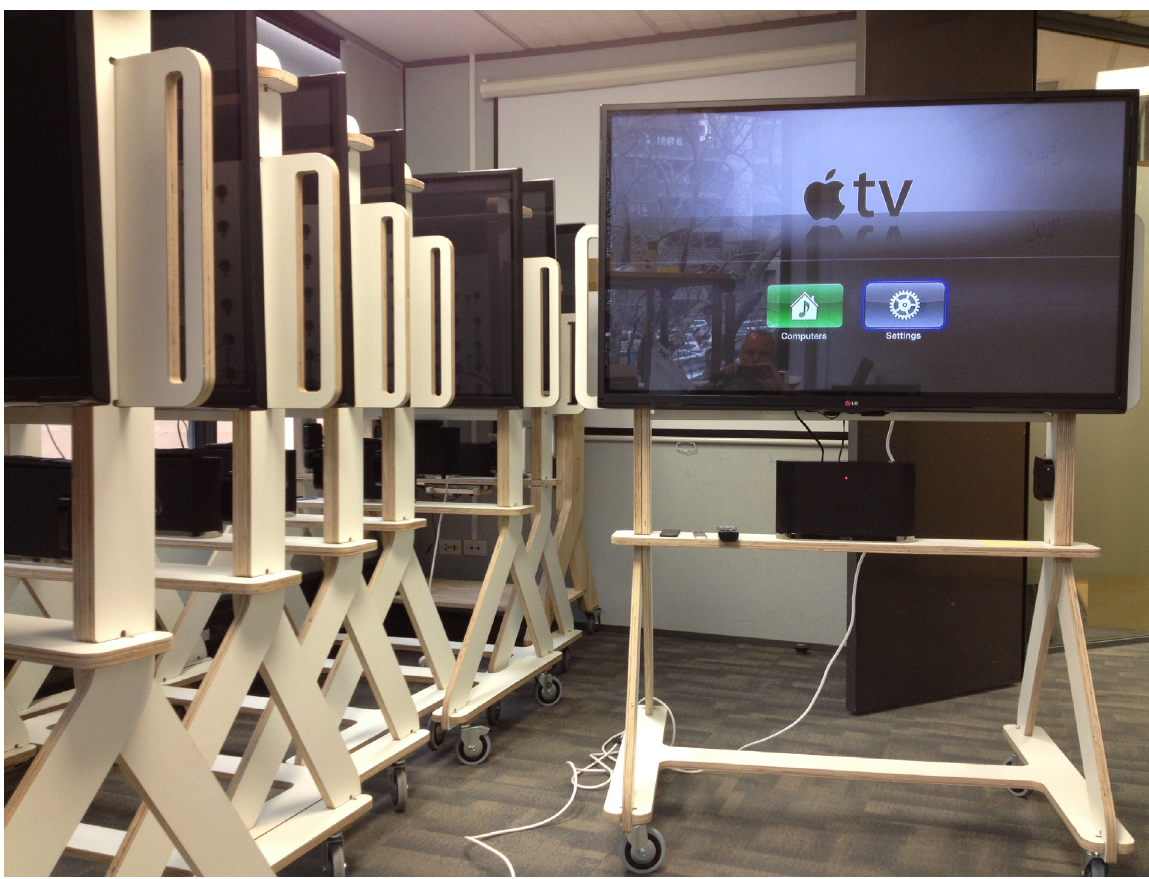
Figure 2. A flock of